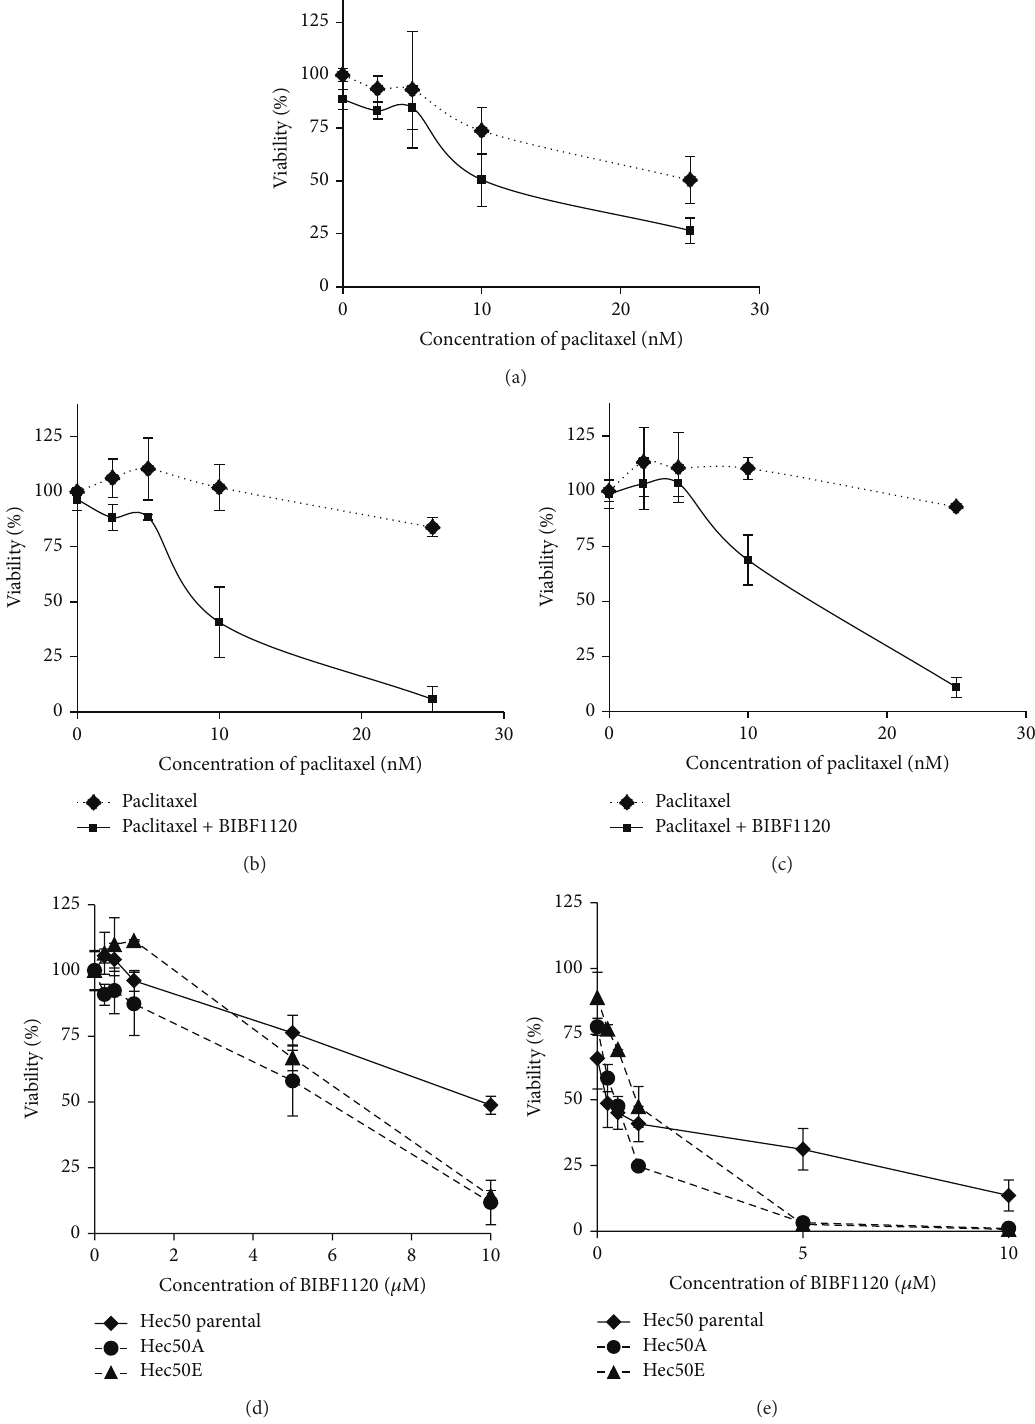
Figure 2: Angiokinase inhibitor BIBF1120 increases sensitivity to paclitaxel in parental and paclitaxel-resistant Hec50 cells. (a–c) Parental Hec50 (a) or paclitaxel-resistant Hec50A (b) or Hec50E (c) endometrial cancer cells, which are p53-null, were treated with increasing concentrations of paclitaxel in the absence or presence of 1 𝜇 M BIBF1120 for 72h, followed by assessment of cell viability using the Wst-1 assay. (d, e) Parental Hec50 or paclitaxel-resistant Hec50A or Hec50E endometrial cancer cells were treated with increasing concentrations of BIBF1120 in the absence (d) or presence (e) of 10nM paclitaxel for 72 h, followed by assessment of cell viability using the Wst-1